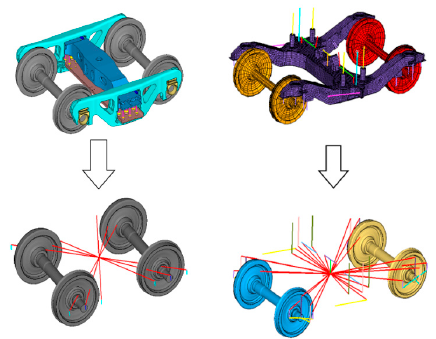
Figure 6. Examples of simplified bogie.